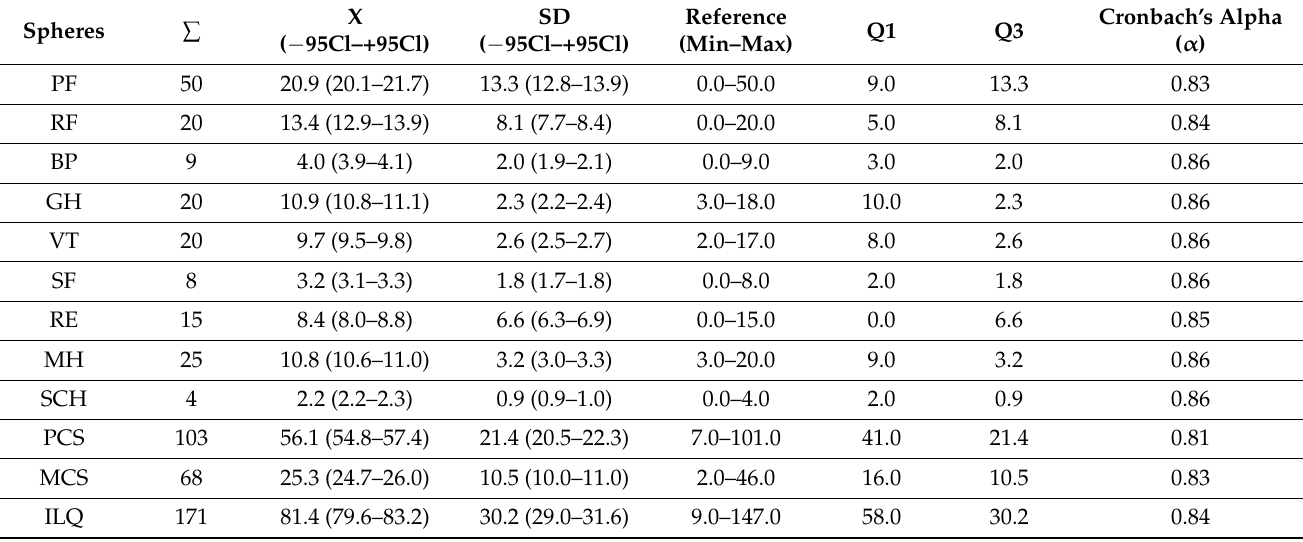
Table 2. The reliability of the SF-36 questionnaire in the examined Polish group of healthy people and the distribution of the values of variables for the total number of respondents. Data coded in accordance with the Polish adaptation of the SF-36 tool (point